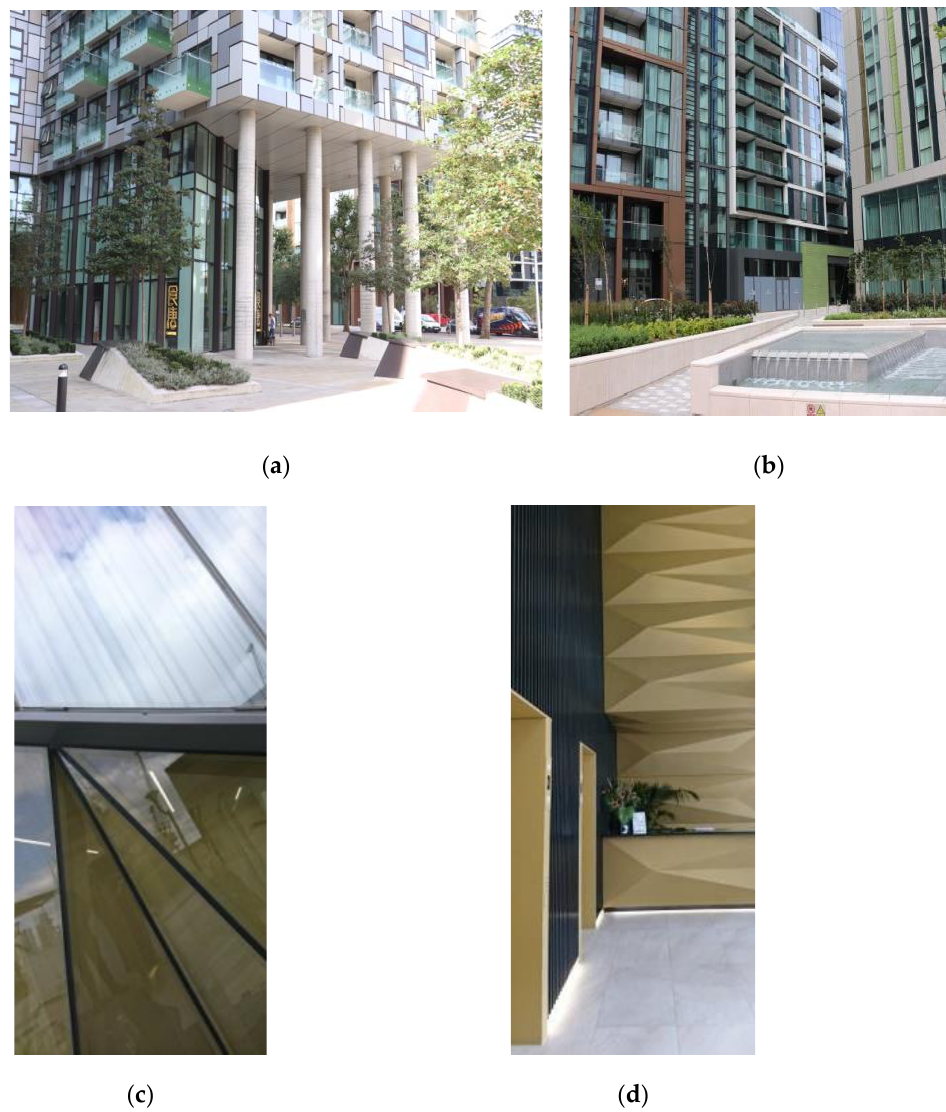
Figure 15. Colours and visual connections at the human scale: ( a ) The Franklin Tower flying over the public realm, colour of the support columns and their slenderness visually connect the building with the public realm (2020); ( b ) Variety of colours at the ground level of Harbour Central buildings: Maine tower to the left and Sirocco Tower to the right (2020). ( c ) One Dollar Bay: Ground floor folded glass panels with laminated golden mesh; ( d ) One Dollar Bay: Similarly folded interior cladding of the lobby painted in golden colour.